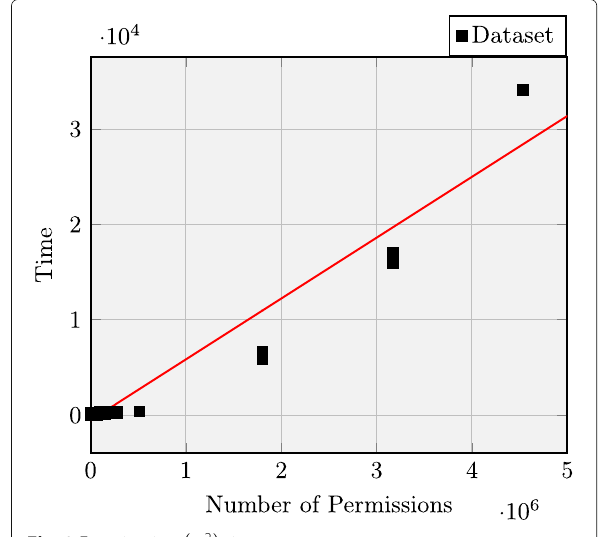
amount of time required is shown against the number of permissions processes. In both figures there are clusters of data points which represent each directory complexity (2, 3, 4, and 5 in order of left to right). In addition, a lin- ear line of best fit is included to show the rate at which time increases along with the number of permissions. This allows for the visual identification of the increase in com- putation time with the increase on the total number of permission entries. As demonstrated in both Figs. 2 and 3, the increase is linear and indicates good scalability as the number of permissions